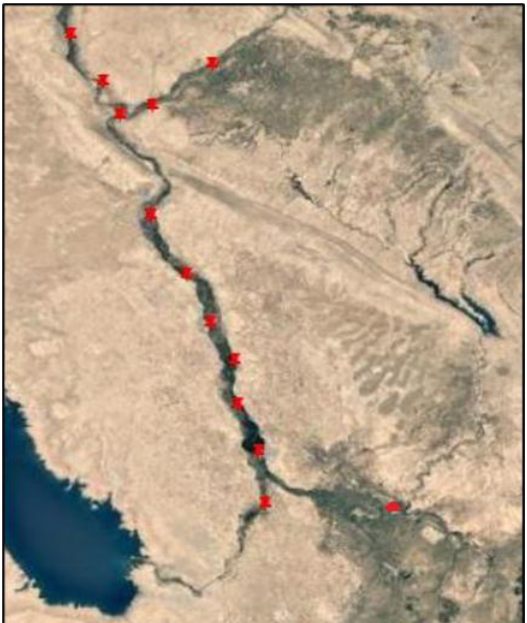
Fig.2: Google satellite image showed the selected points along the Tigris River in Salah Al-Din